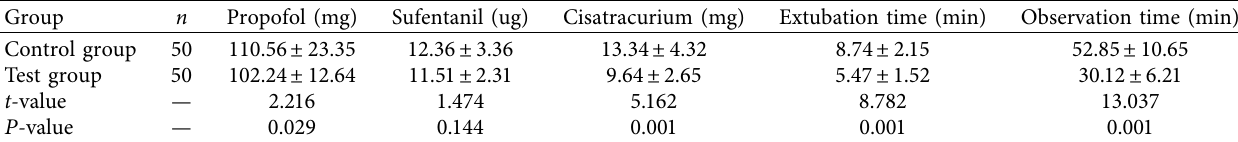
Table 2: Comparison of anesthesia dose, extubation time, and observation time between two groups of patients ( x ± s ).